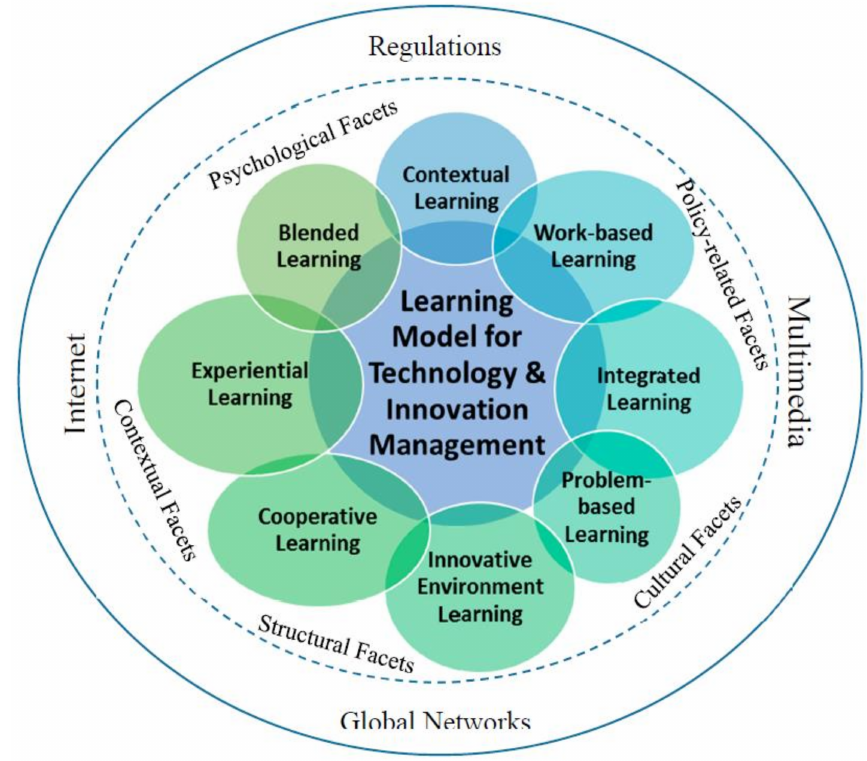
Figure 3. Learning Model for Technology and Innovation Management. Source: own